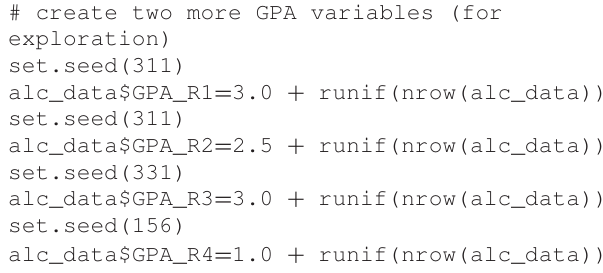
computed, rounded to 2 digits, and annotated on the plot at position x = 3.1, y = 4.0, with a 40% larger font than default; the text is adjusted so that the bottom-left of the first character coincides with the specified